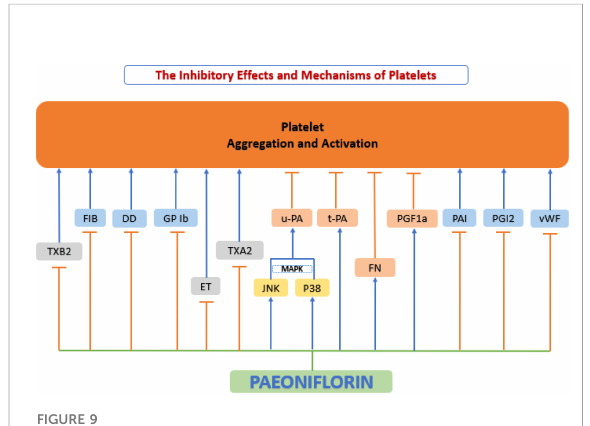
FIGURE 9 Anti-platelet function of paeoni fl orin. Paeoni fl orin exerts an important antithrombotic function by inhibiting platelet aggregation and activation. DD, d-dimer; ET, endothelin; FIB, fi brinogen; FN, fi bronectin; GP Ib, glycoprotein Ib; JNK, c-Jun N-terminal kinase; MAPK, mitogen-activated protein kinase; p38, p38 mitogen-activated protein kinase (MAPK); PAI, plasminogen activator inhibitor; PGF1a, 6-keto prostaglandin Fla; PGI2, prostacyclin; t-PA, tissue-type plasminogen activator; TXA2, thromboxane A2; TXB2, thromboxane B2; u-PA, urokinase-type plasminogen activator; vWF, von Willebrand